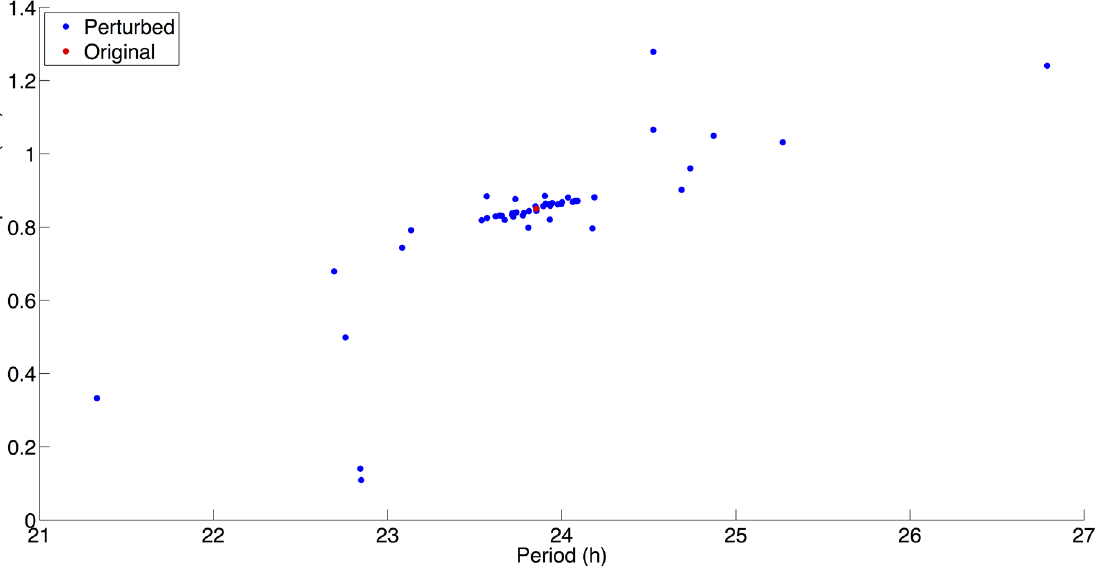
Fig 4. Model robustness as indicated by alterations in maximum peak-to-peak amplitude and period. Red: Current model parameter values. Blue: Perturbed parameter values individually increased and decreased by 20%.